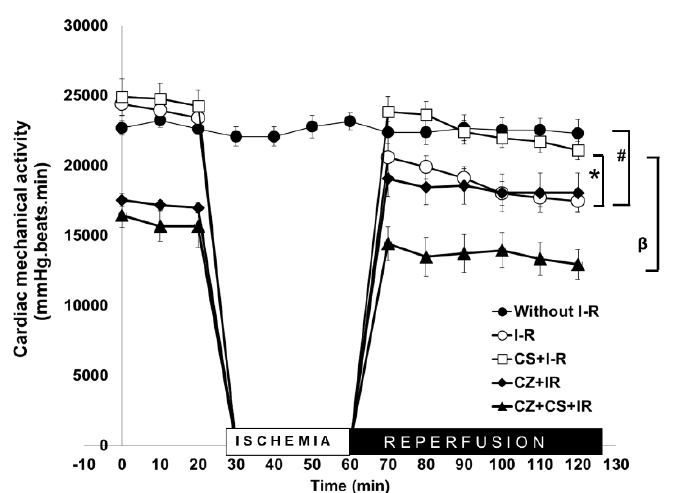
Figure 2. Cardiac mechanical activity in isolated and perfused hearts with perfusion (30 min), global ischemia (30 min) and reperfusion (60 min) periods for rats without treatment and after treatment with CS, CZ and combination CZ+CS. Values are the mean ± SE ( n = 10 in each group) p ≤ 0.05 * CS + I-R vs. I-R; # Without I-R vs. I- R; β CS + I -R vs. CZ+CS + I-R.